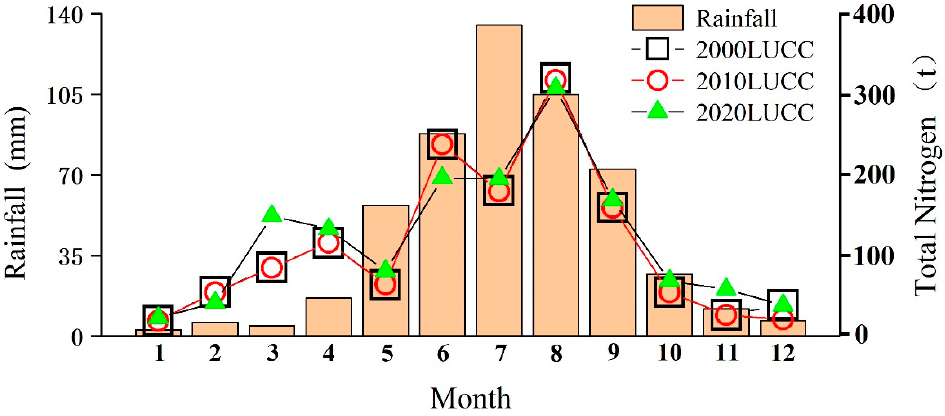
Figure 17. Monthly loadings of total annual nitrogen under three land use phases.